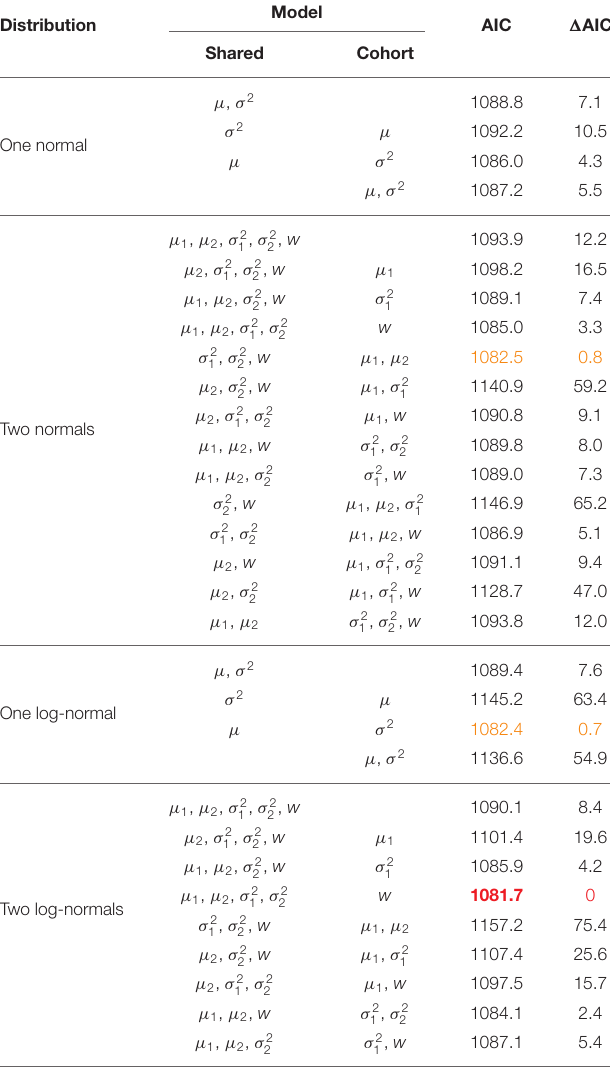
TABLE 1 | Fitted models with AIC and 1 AIC scores for the Isle of May gray seal study.